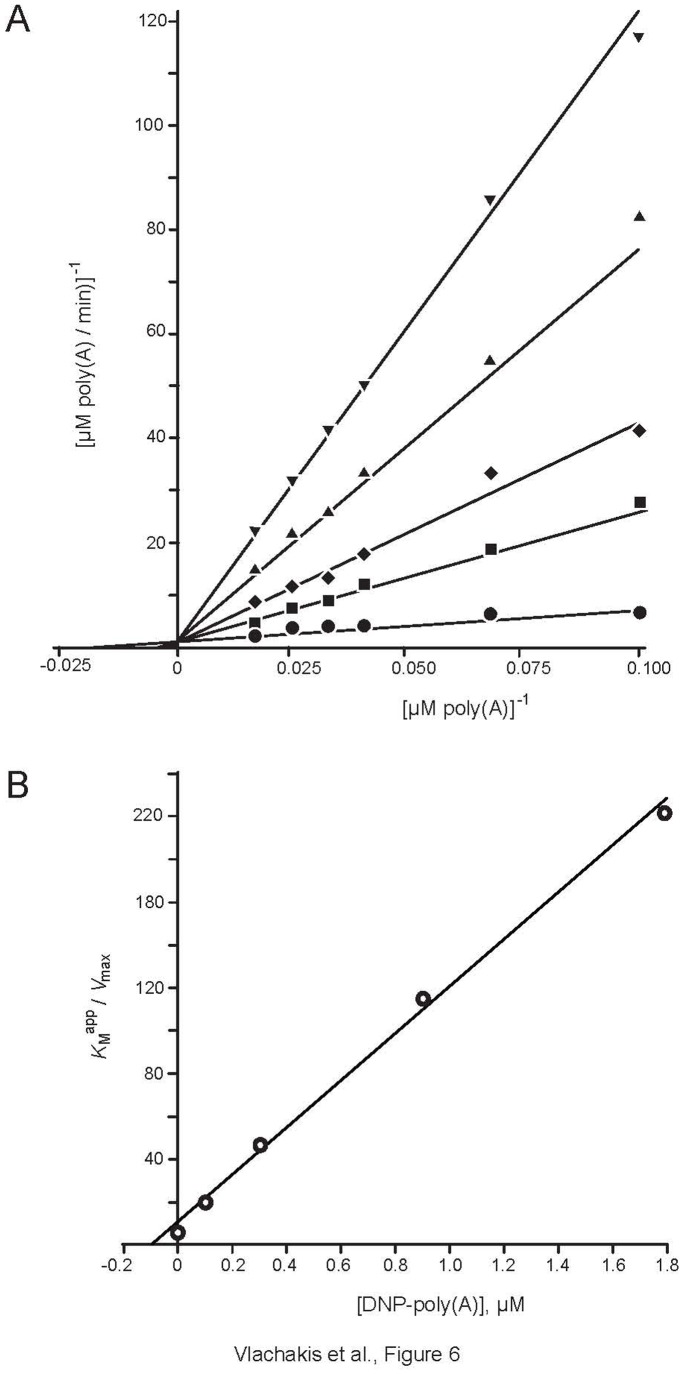
DNP-poly(A) is a competitive inhibitor of PARN.(A). Double reciprocal plots 1/v versus 1/[substrate] for PARN activity in the presence or absence (•) of DNP-poly(A) are shown. The DNP-poly(A) concentrations are 0.1 (▪), 0.3 (⧫) and 0.9 (▴) and 1.8 (▾) mM. Representative plots of at least three independent experiments. Substrate concentrations range from 0.1–0.6 mM poly(A). (B). The slopes (K
M
app/V
max) of the double reciprocal lines are plotted versus the DNP-poly(A) concentration used to calculate the K
i value. The intercept of line on x-axis represents –K
i.